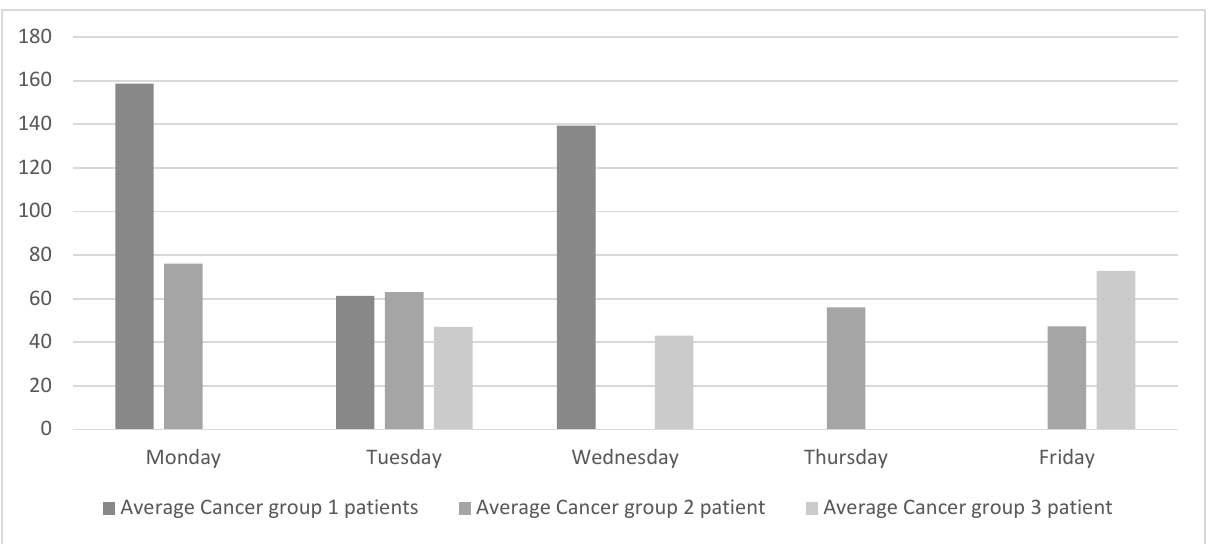
Figure 3. Current daily average of oncology patients seen by the medical oncologist.